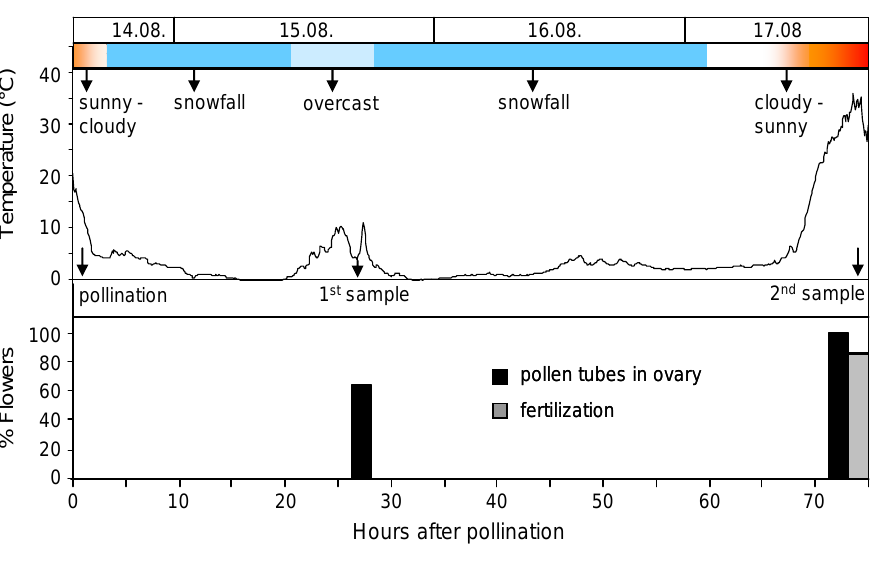
Figure 4. Weather conditions, temperature course and pollen performance in S. caesia during a cold snap at the alpine site (14–17 August 2005). Bars in the lower graph show the percentage of investigated flowers with pollen tubes in the ovary, and with fertilized ovules,